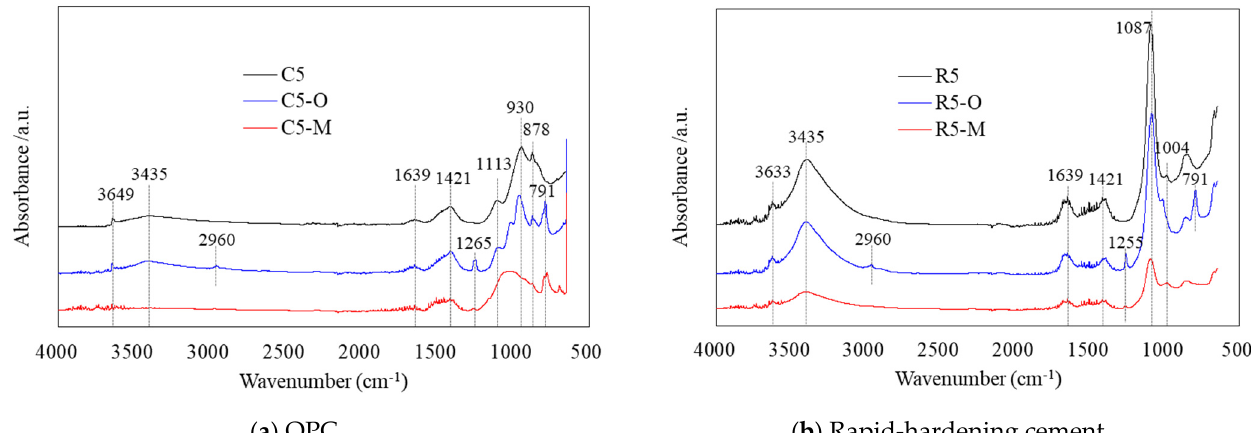
Figure 8. FT-IR spectra of the cement mortar mixed with water